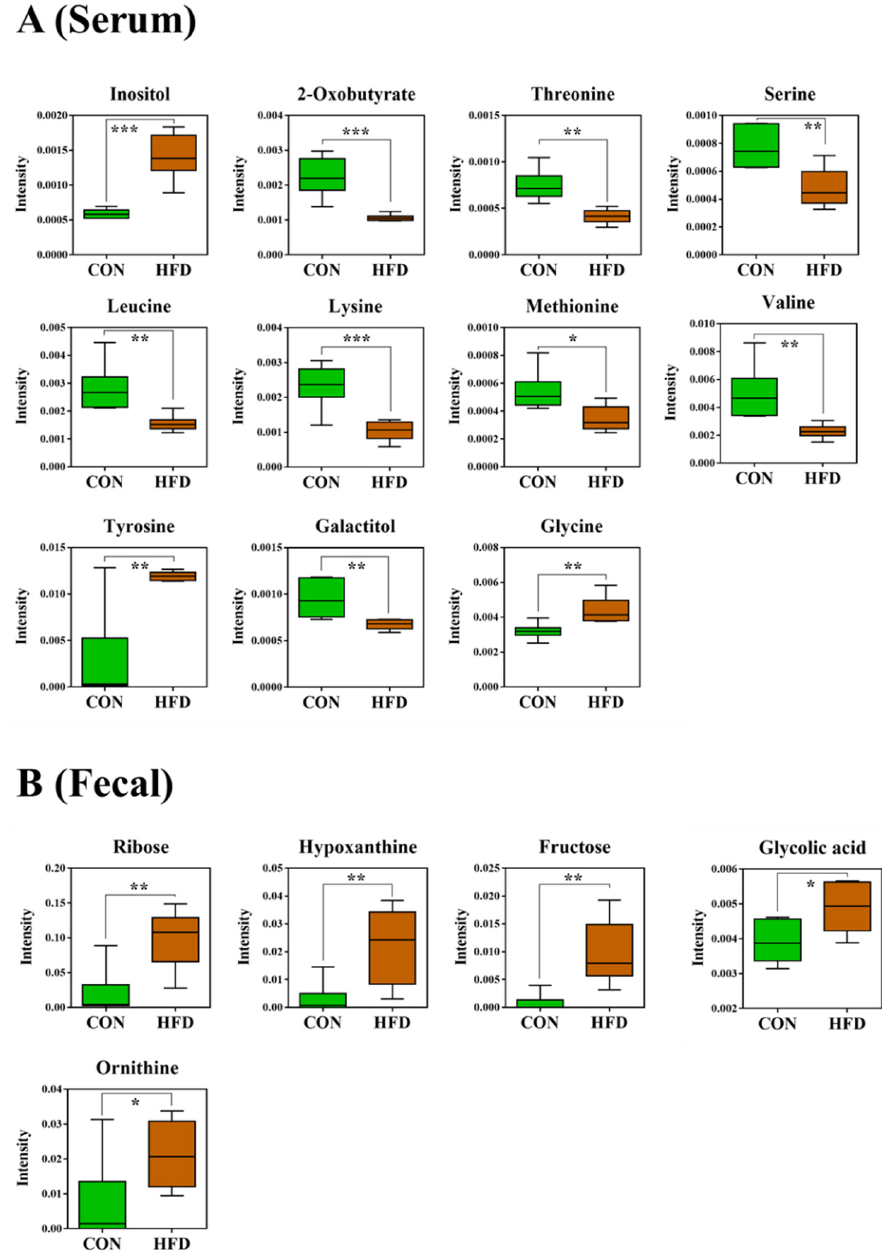
Figure 5. Box plots of significantly different metabolites in ( A ) serum and ( B ) fecal samples of the HFD and control groups. *, p < 0.05; **, p < 0.01; ***, p < 0.001. A false discovery rate of 5% was applied to all tests to correct for multiple testing.